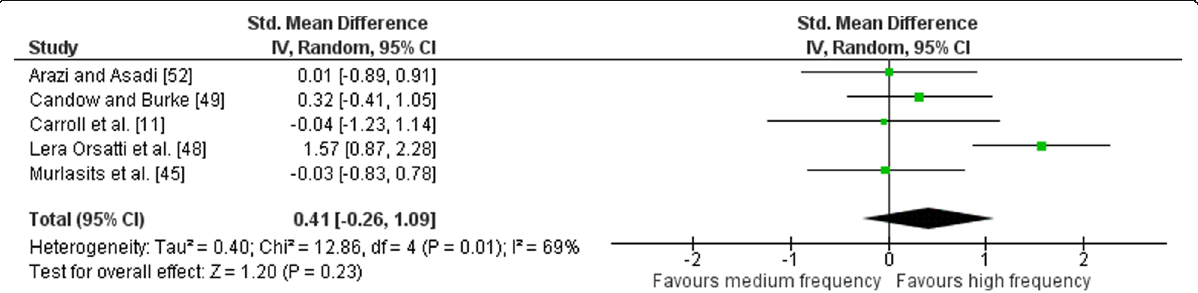
Fig. 13 Medium vs. high weekly training frequency. Pre- vs. post-mean ES strength difference on lower body exercise. The vertical line indicates the overall estimate of combined multi-joint and isolation studies pre- vs. post-mean ES strength difference. Horizontal lines indicate 95% CI, squares estimates, whereas square size is proportional to sample size, and rhombs ’ meta-analytically pooled